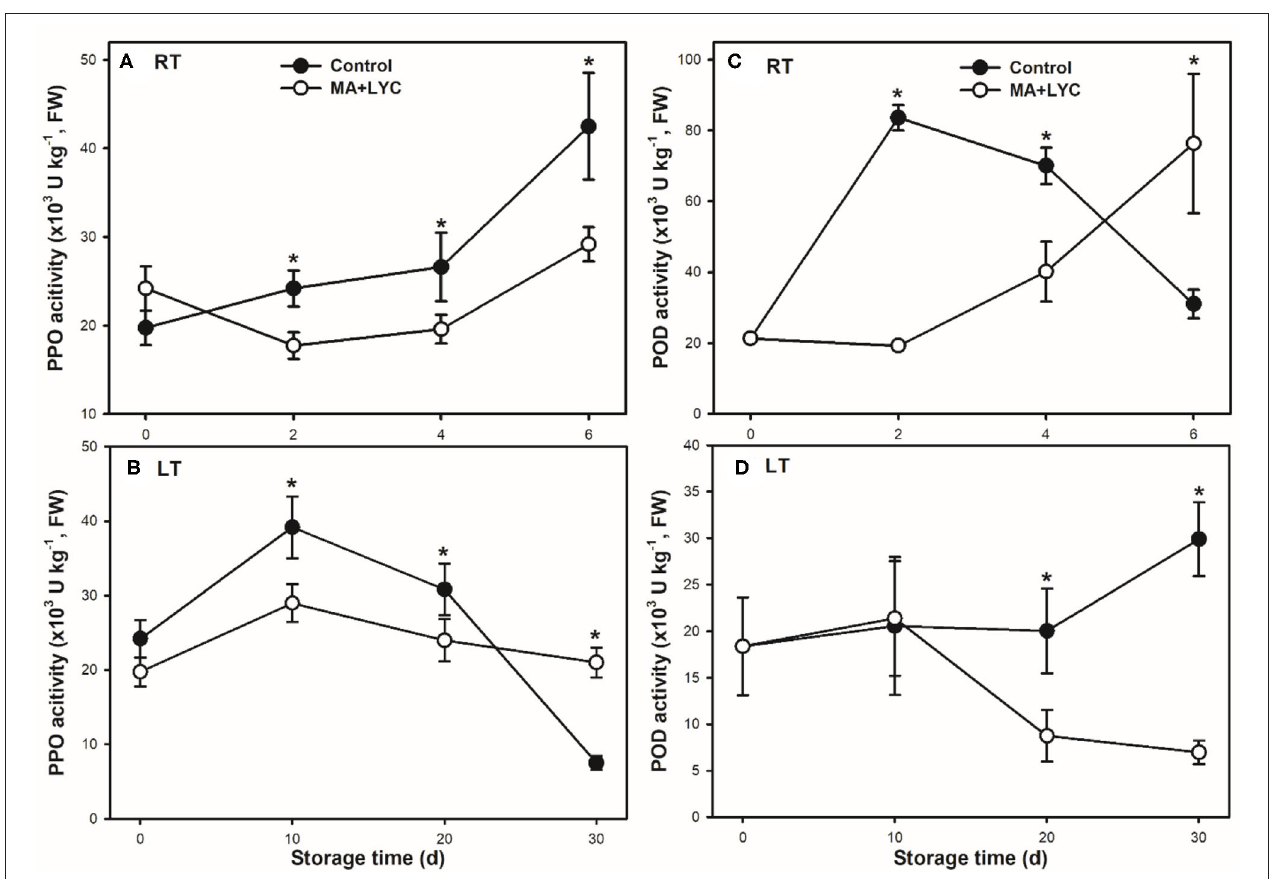
FIGURE 4 | Enzyme activities of PPO (A,B) and POD (C,D) in litchi pericarp stored at RT (25 ◦ C) and LT (4 ◦ C), respectively. Data are represented by mean values with the SD. Asterisk indicates the significant difference of means at 0.05 level.